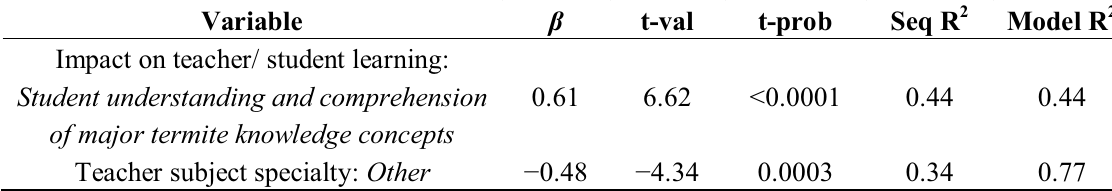
Table 5. Regression of 43 Educate to Eradicate (cid:83)(cid:68)(cid:85)(cid:87)(cid:81)(cid:72)(cid:85)(cid:3)(cid:87)(cid:72)(cid:68)(cid:70)(cid:75)(cid:72)(cid:85)(cid:86)(cid:182)(cid:3)(cid:83)(cid:85)(cid:82)(cid:77)(cid:72)(cid:70)(cid:87)(cid:3)(cid:70)(cid:82)(cid:81)(cid:87)(cid:76)(cid:81)(cid:88)(cid:68)(cid:87)(cid:76)(cid:82)(cid:81)(cid:3) on perceptions of curriculum and teacher characteristics (survey